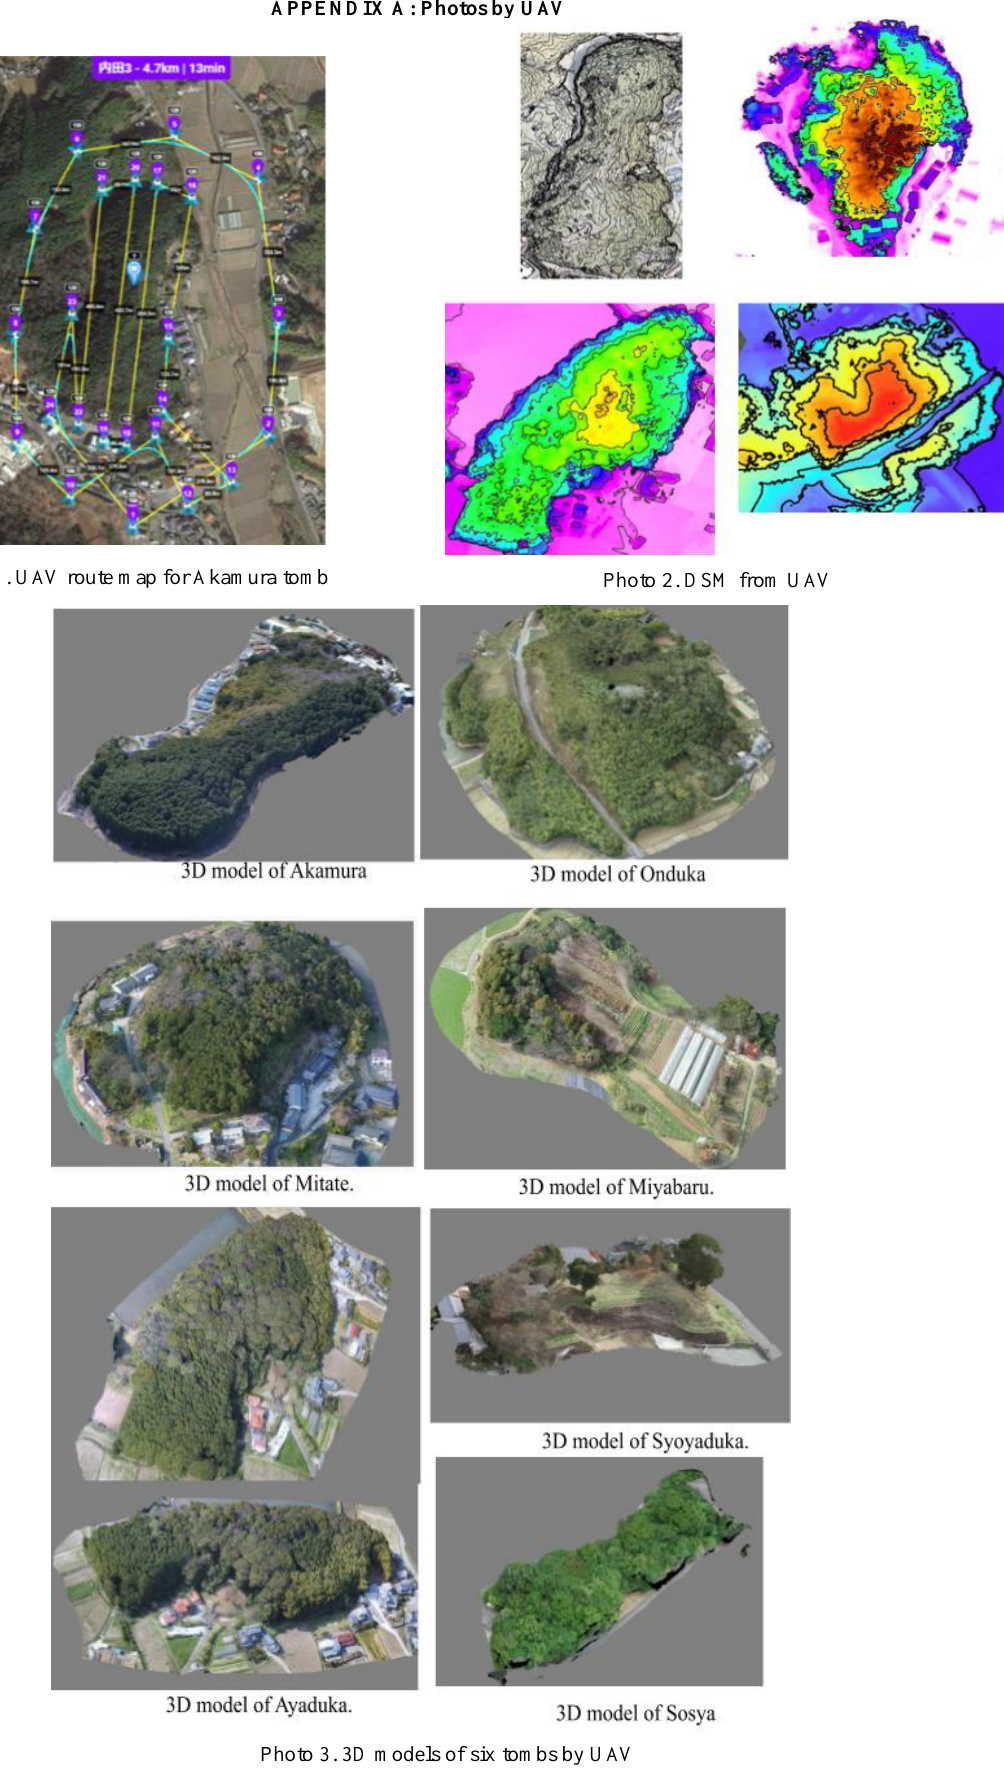
Photo 3. 3D models of six tombs by UAV